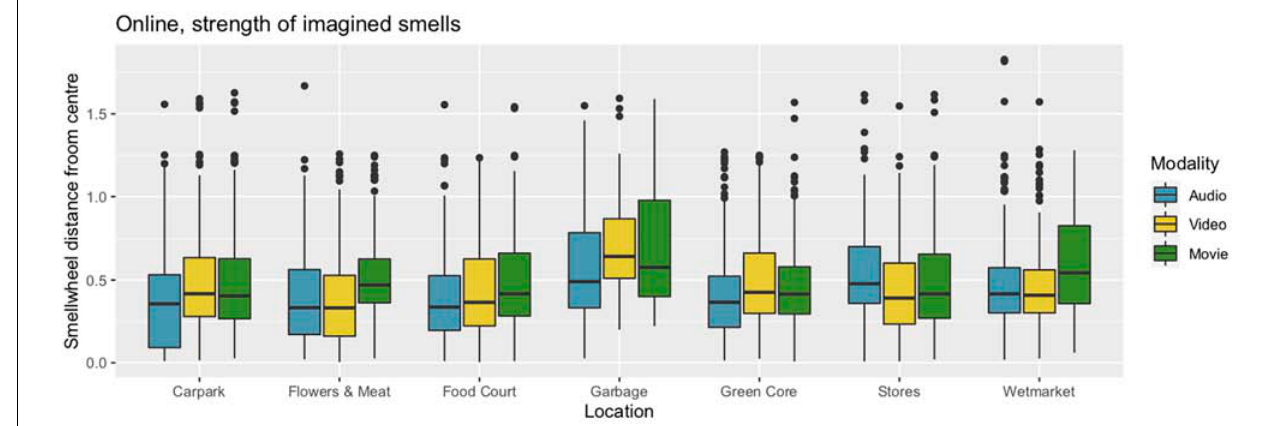
FIGURE 8 | Imagined smell intensity (proxied by mouse-click distance from smellwheel centre; see the text for details) in seven locations and three audiovisual modalities.